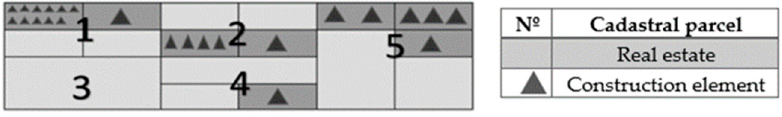
Figure 2. Example of organization of cadastral information. Own preparation.